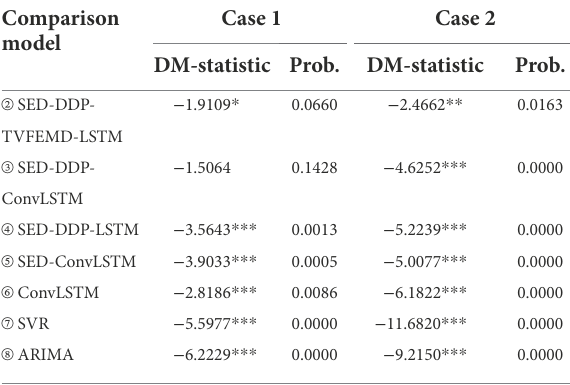
TABLE 3 DM test results of the proposed model and the comparison models. Comparison